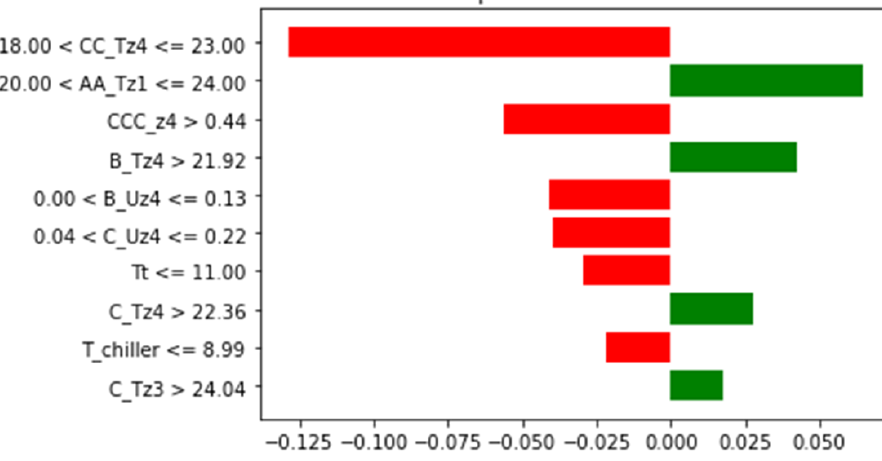
Figure 4. Local Explanation of XGBoost using LIME. Figure 4 . Local Explanation of XGBoost using LIME .